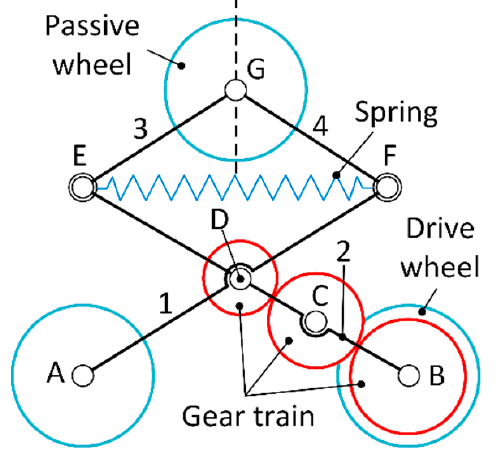
Figure 11. Inspection robot with pantograph linkage.